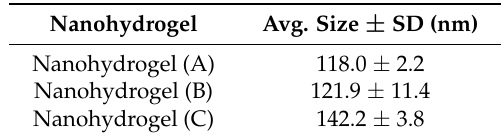
Table 2. The size distribution of the nanohydrogels.